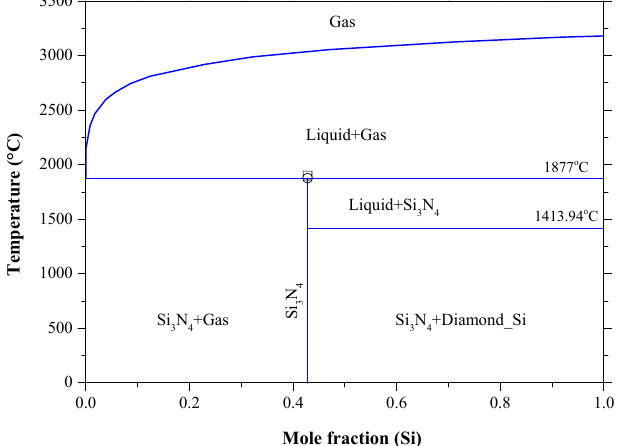
Figure 24. The N-Si binary phase diagram calculated by Ma et al. [214] at 1 atm; ○ : [221]; □ : [223].